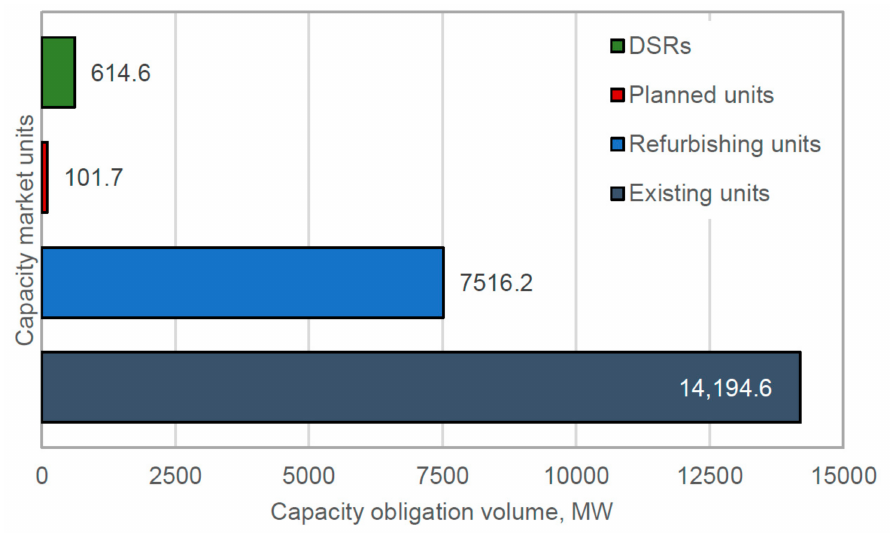
Figure 4. Capacity obligation volume contracted in main capacity auction for 2021 delivery year– break down by real status of capacity market units. Source: Own analysis based on [37].